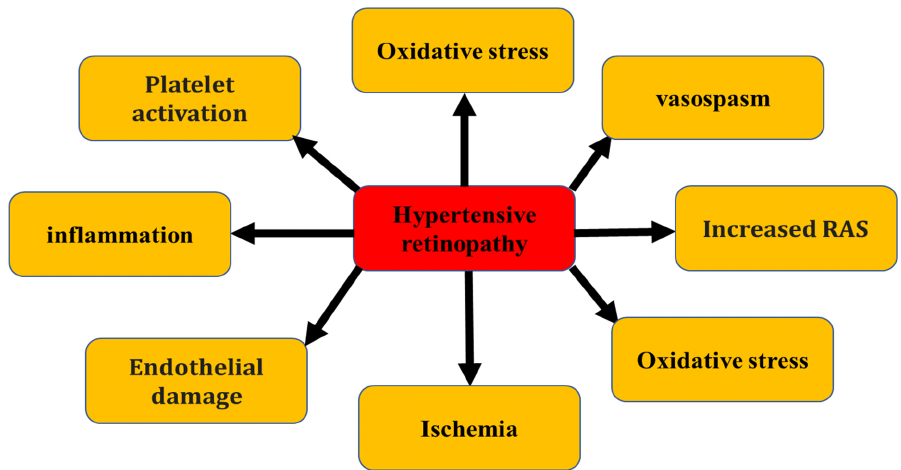
Figure 3. Factors involved in the pathogenesis of hypertensive